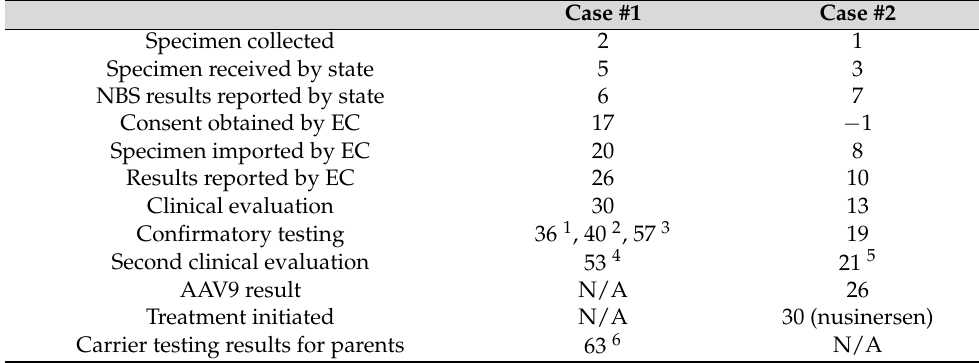
Table 3. Screen-positive testing and reporting timeline. Values are given in days after